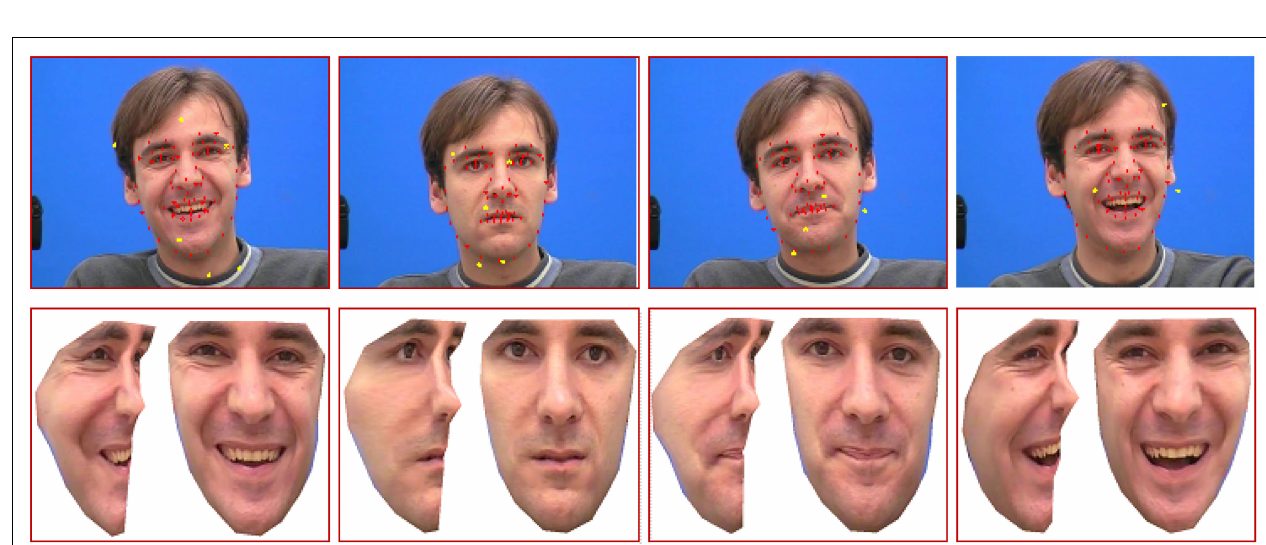
FIGURE 7 | Test results of the face sequence . (top) Four frames from the sequence overlaid with the tracked features (red circles) and added outliers (blue stars); (bottom) the corresponding 3D VRML models from two different viewpoints.